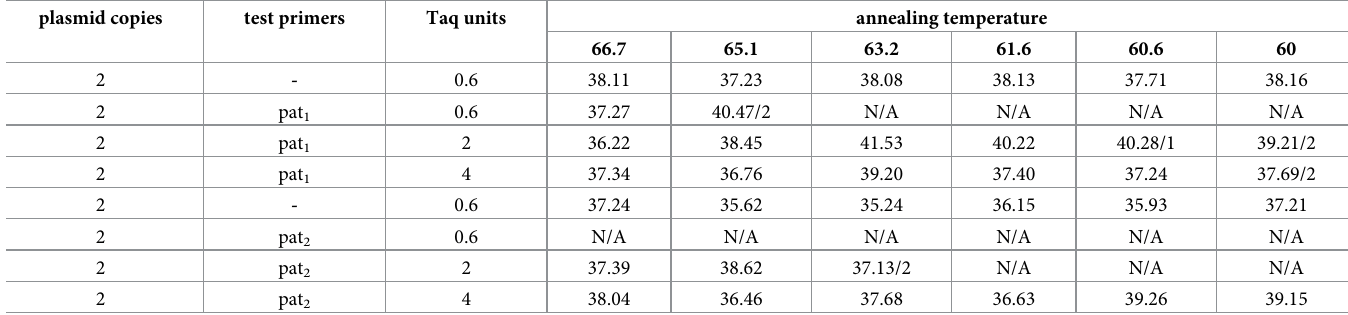
Table 2. Effect of annealing temperature and Taq concentration on inhibition. plasmid